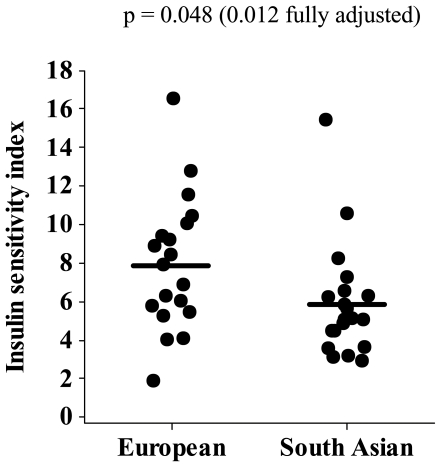
Individual insulin sensitivity index values for the European and South Asian men.Horizontal bars denote mean values. P values shown are for the difference between European and South Asian groups, either unadjusted, or adjusted for age, BMI and fat mass.